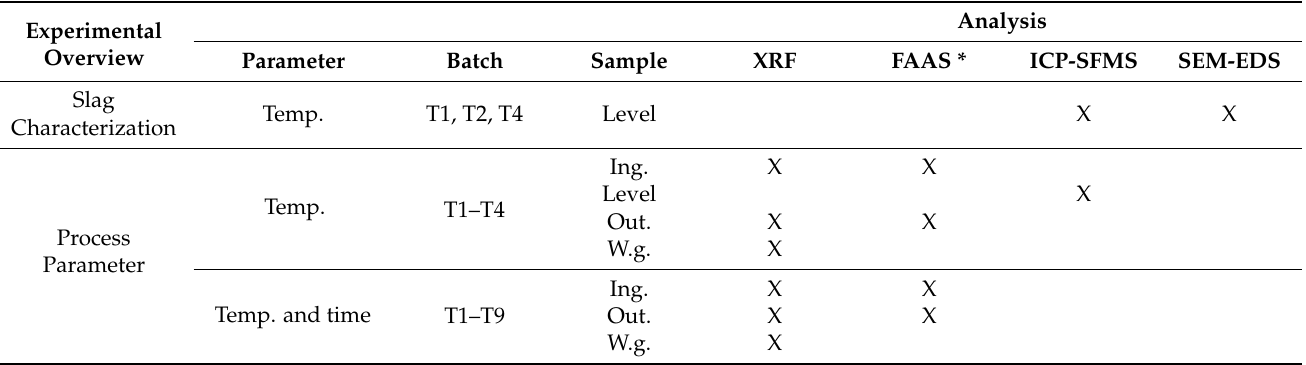
Process Parameter